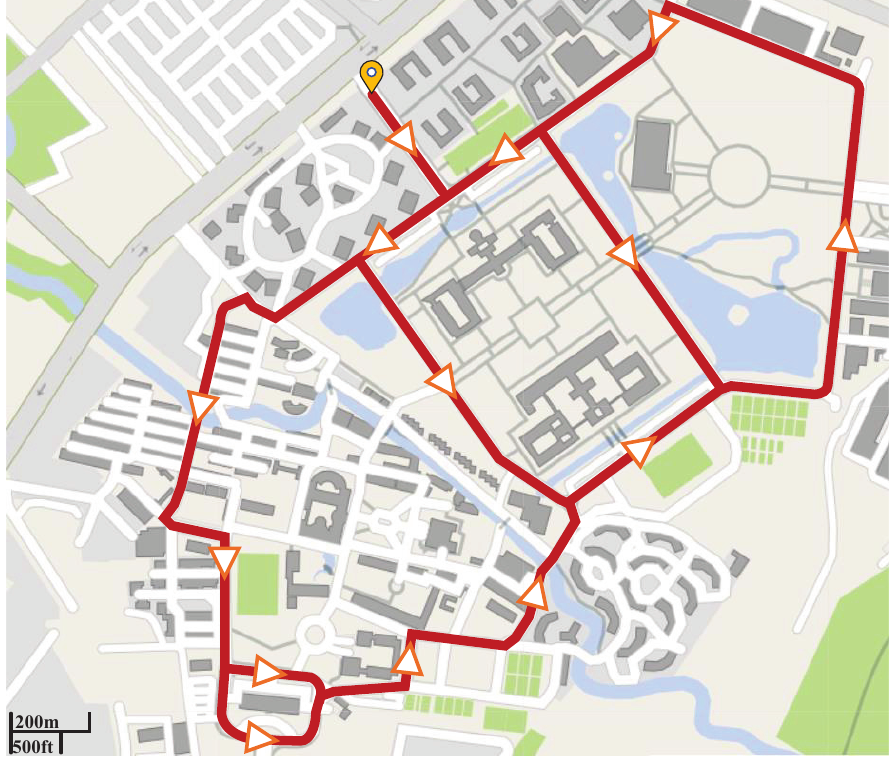
Figure 4. Map of the driving